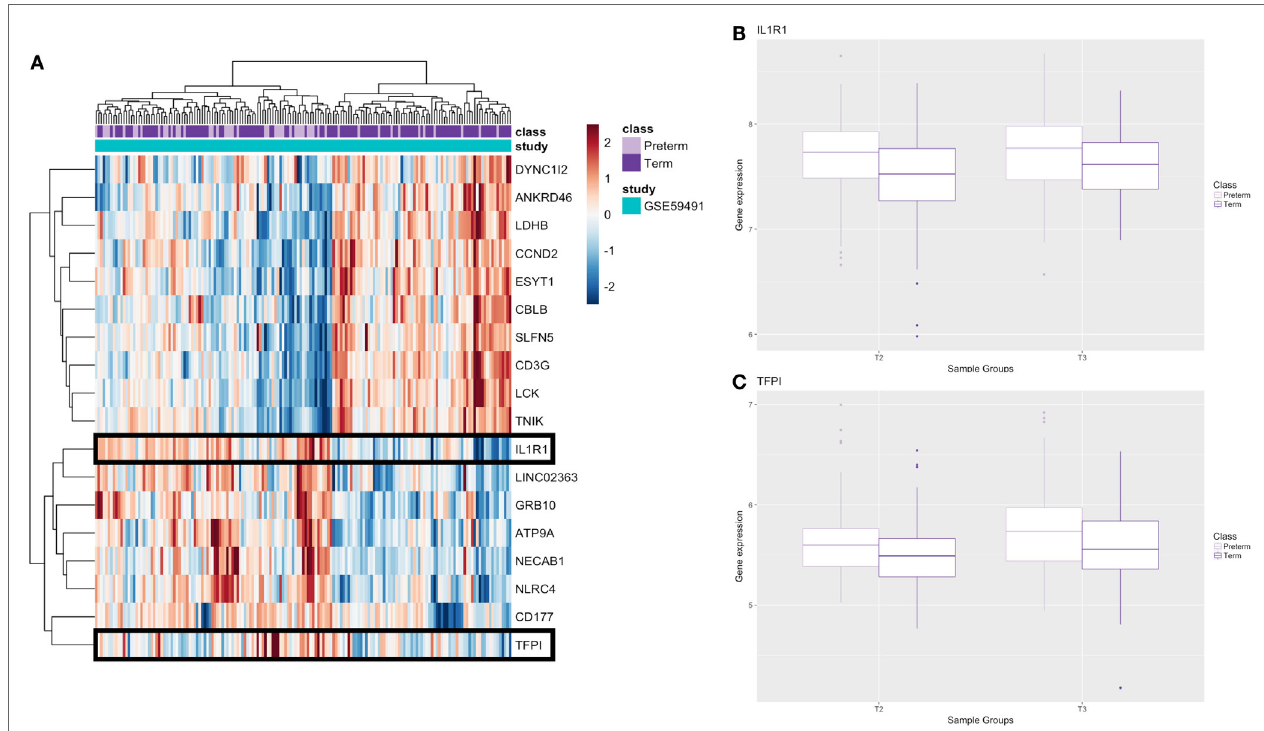
FiGURe 6 | Results from additional second trimester analysis. (a) Heatmap of significant genes from second trimester analysis; genes which are secreted as proteins are boxed. (B,c) Boxplots of genes that encode secreted proteins at second (T2) and third (T3) trimester; raw gene expression values from GSE59491 are